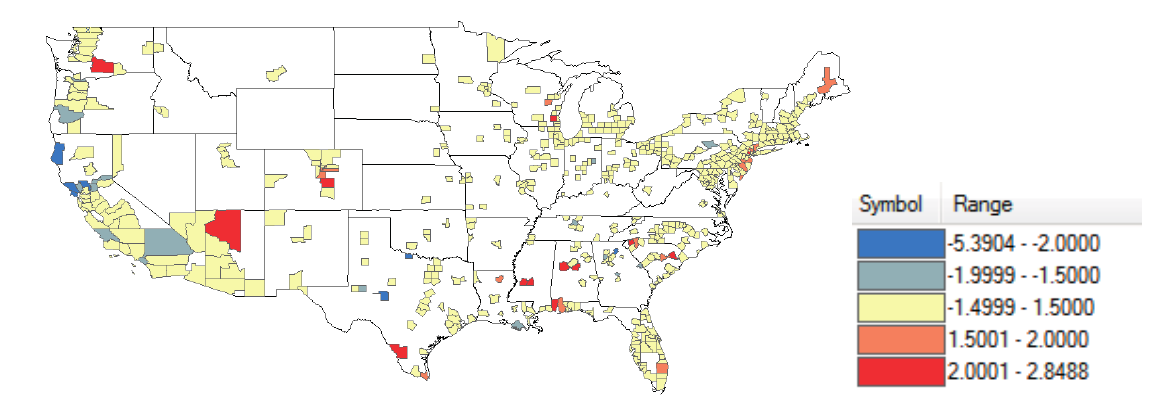
Figure 3. Mapping of residuals from reduced model taking into account spatial autocorrelation N =